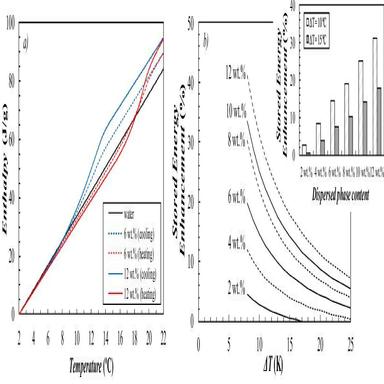
(a) Enthalpy versus temperature curves, taking T = 2 ◦C as reference temperature, and (b) enhancements in thermal energy storage capacity as a function of the temperature interval covered by the thermal fluid, ΔT, for some representative C18Me:C16:C14Me− in− water nanoemulsions. Readers are suggested to refer the electronic version of the article for colors.